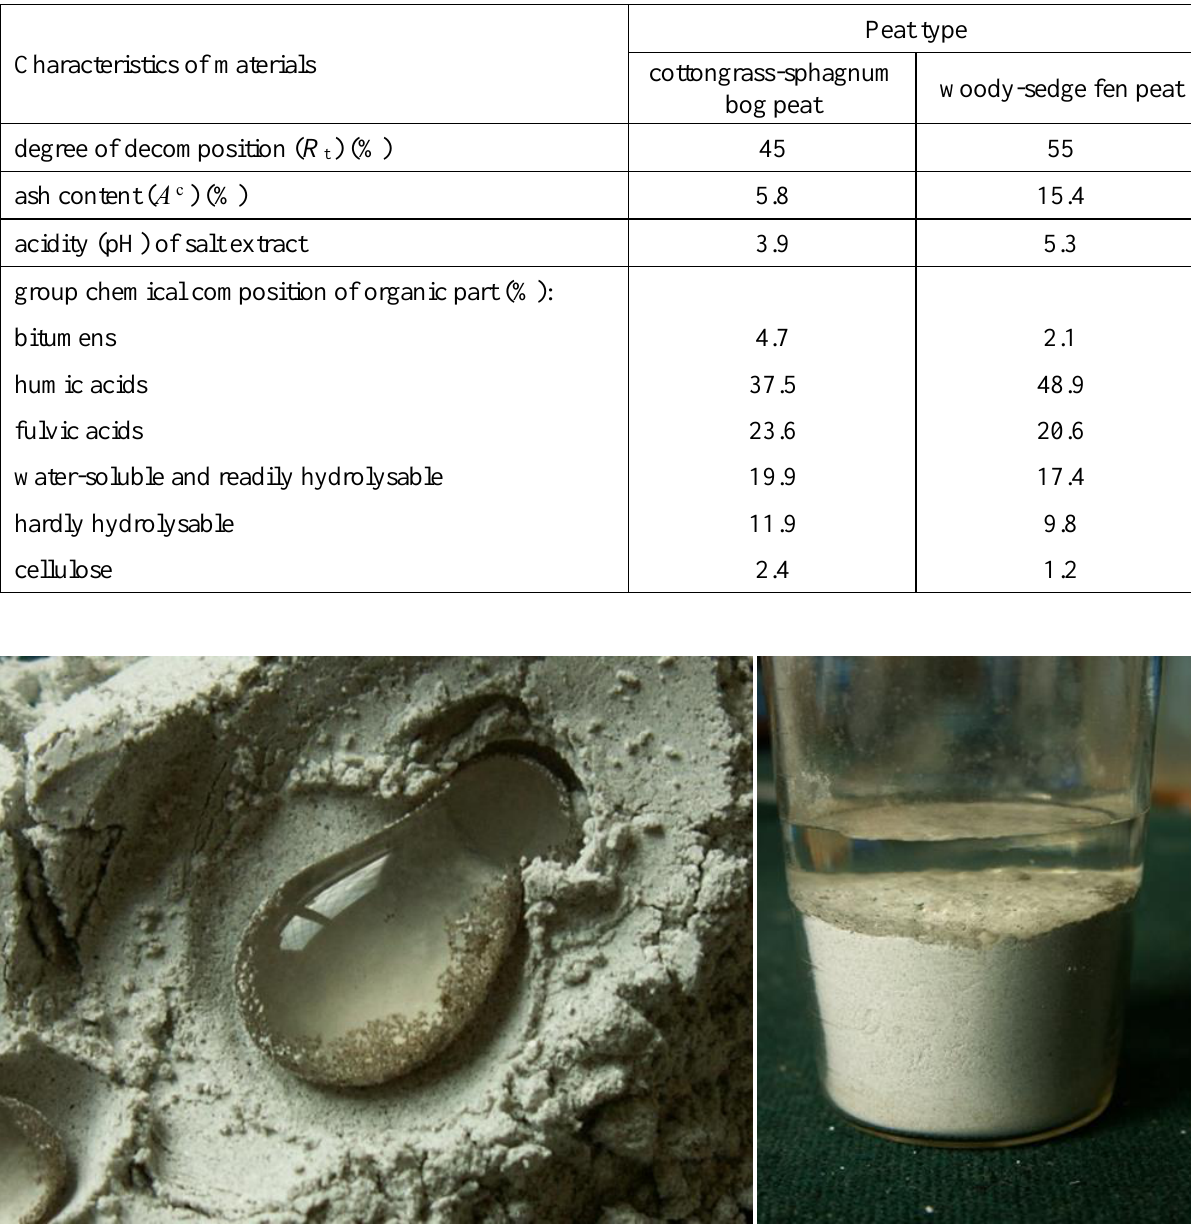
Figure 3. Options for preliminary tests of the hydrophobicity of modified gypsum binder. the surface of a layer of the powder. About 50 g of powder was placed in a Petri dish and its surface was levelled by gently shaking the dish. Then, at least ten drops (~ 0.1 cm 3 per drop) of distilled water were placed on the surface, at least 10 mm apart, using